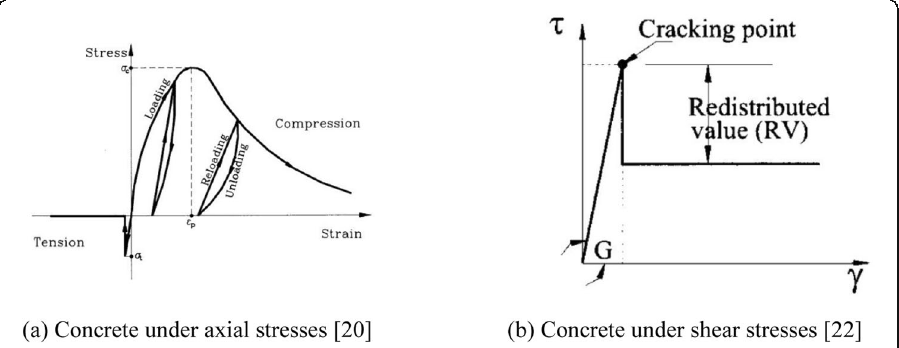
Fig. 6 Constitutive models for concrete used in ELS. a Concrete under axial stresses [21]. b Concrete under shear stresses